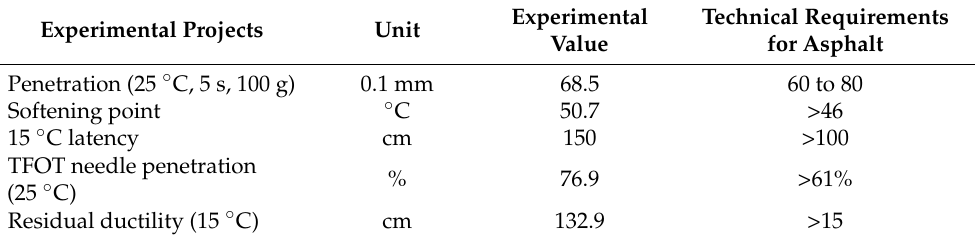
Table 1. Performance index of base asphalt.